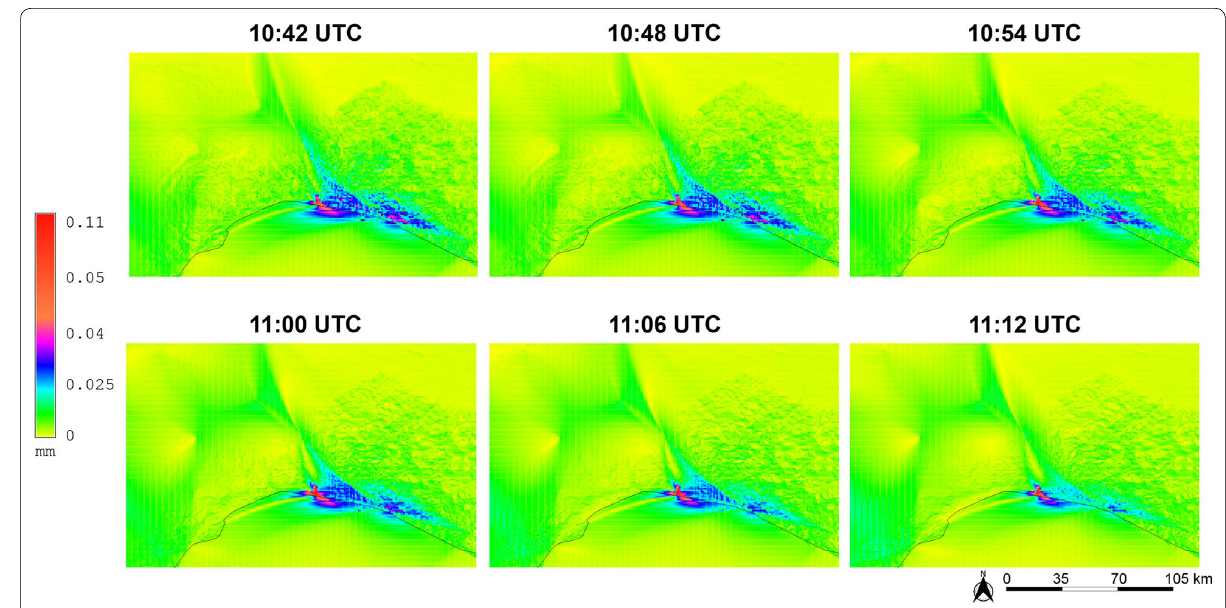
Fig. 19 6-minute HI maps at ~ 11:00 UTC for the severe event on November 4, 2011, as highlighted in the red rectangle in Fig.